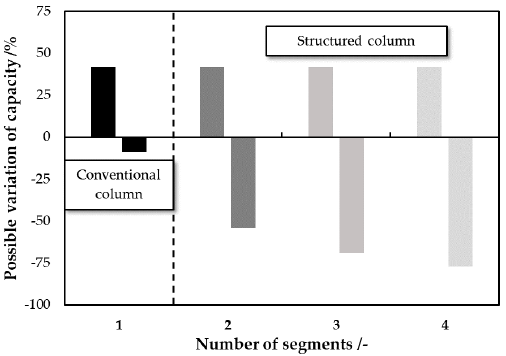
Figure 7. Simulation results on the enhancement of throughput variation within optimal operation range due to an internal segmentation of the column [95].